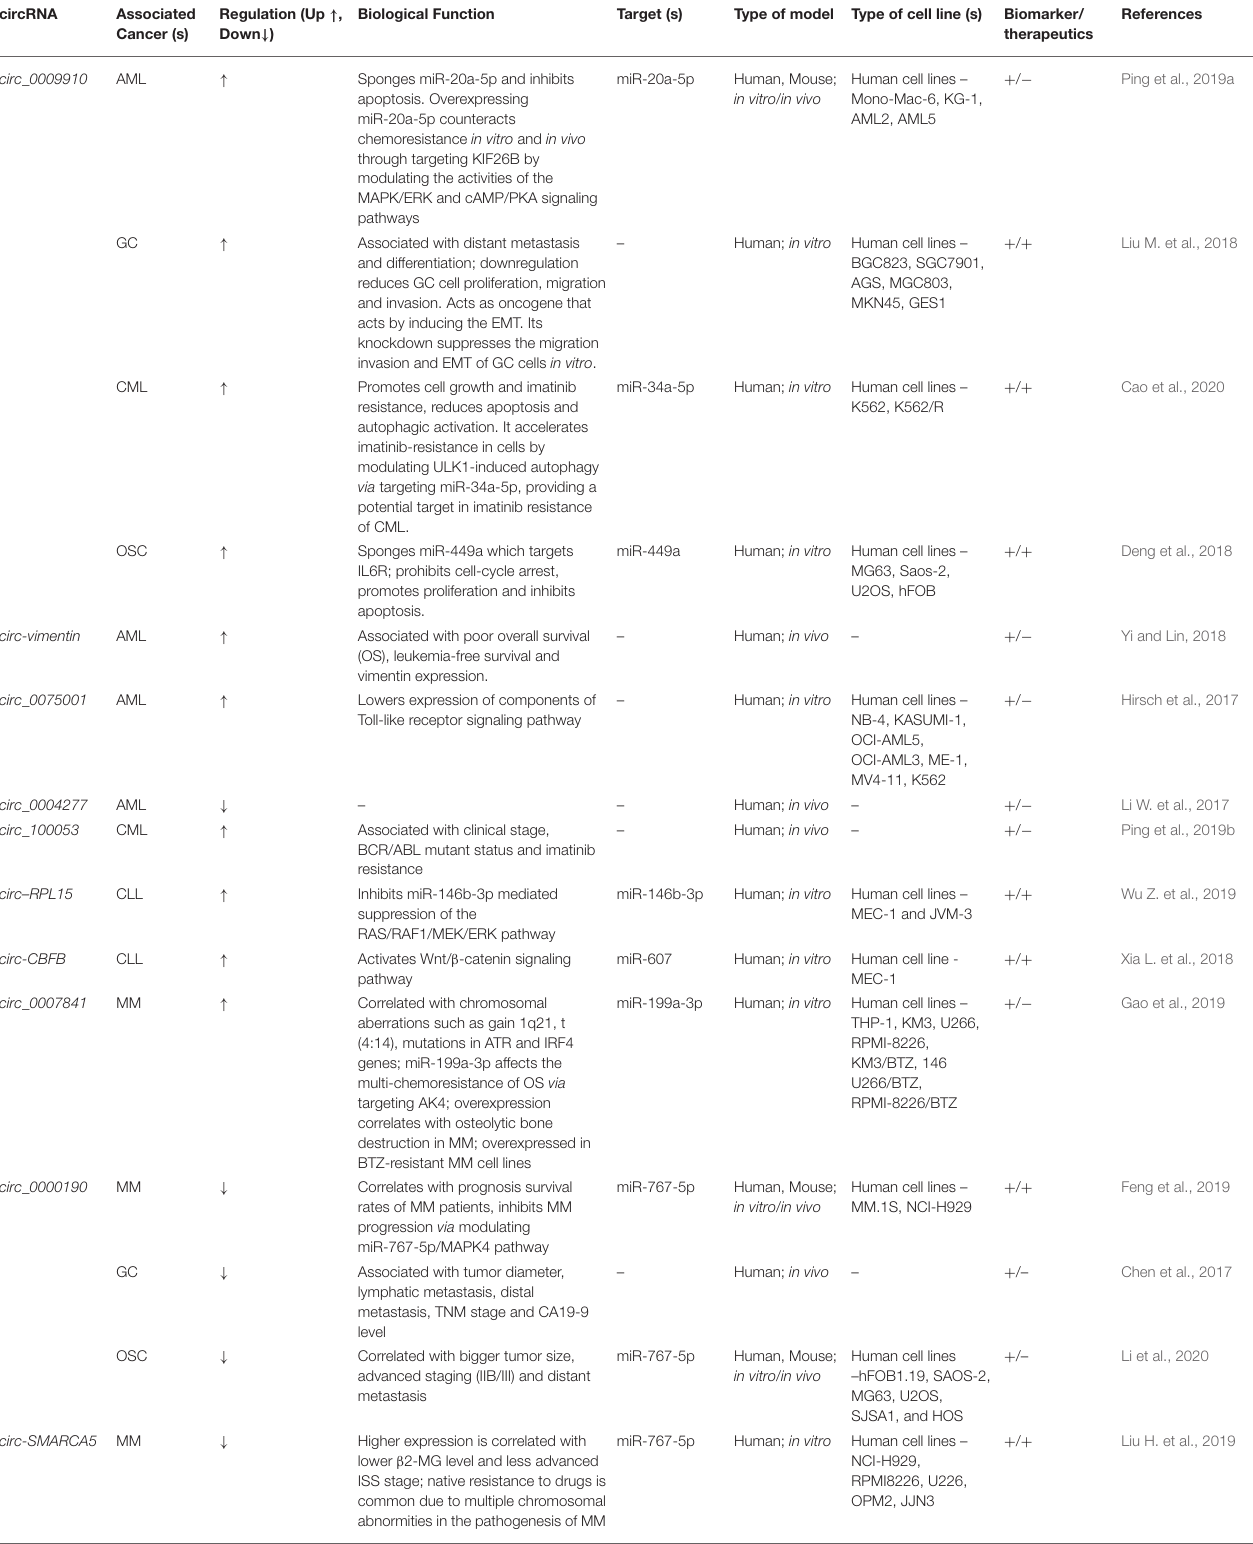
TABLE 1 | Biological functions and roles of circular RNAs in cancer diagnostics and therapeutics.